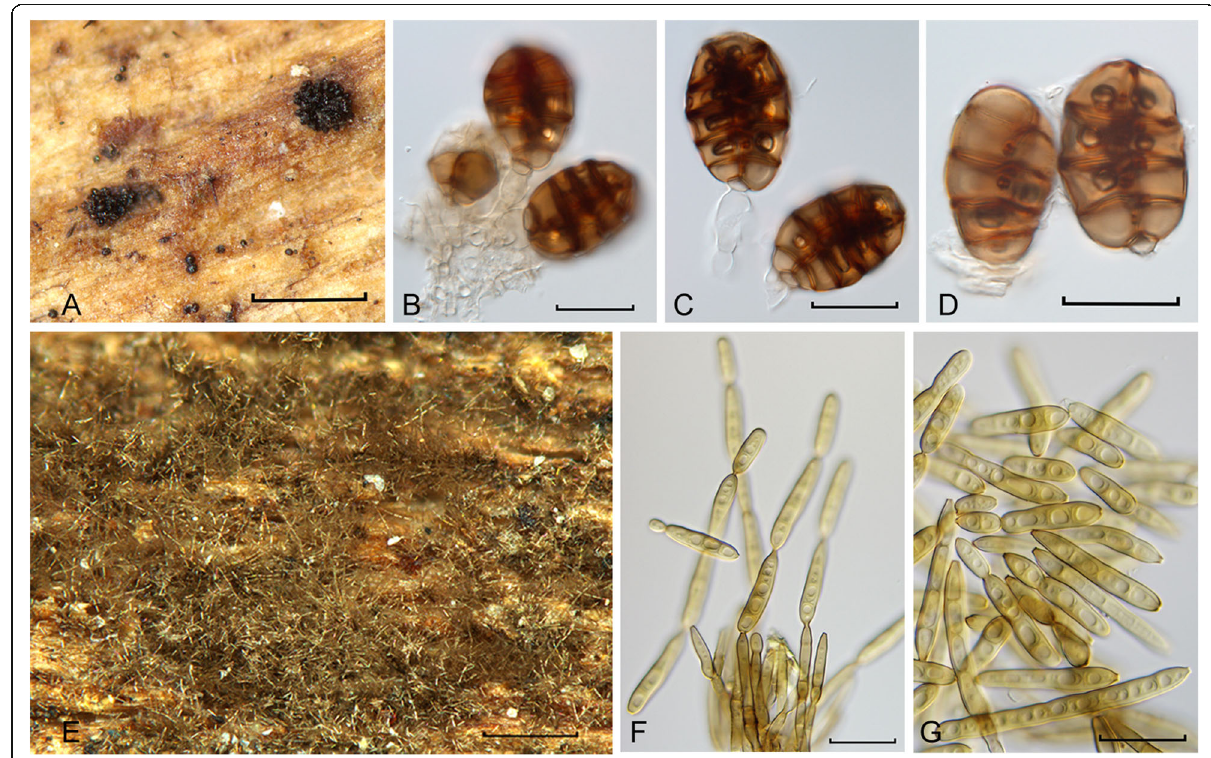
Fig. 1 Canalisporium caribense (PRM 831526, holotype). A. Two pulvinate sporodochia on natural substrate. B , C. Conidia still attached to a conidiogenous cell. D. Detached conidia showing septal pores. Sporidesmium tetracoilum (PRC 4681). E. Colony on natural substrate. F. Chains of conidia produced on conidiogenous cells. G. Conidia. Scale bars A , E = 250 μ m, B – D , F , G = 20 μ